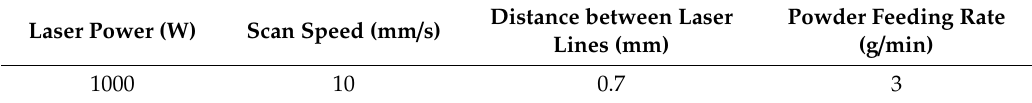
Table 3. Direct Laser Deposition control